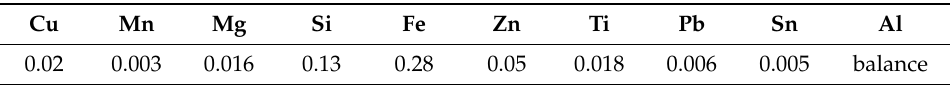
Table 1. Chemical composition of the Al-bar.